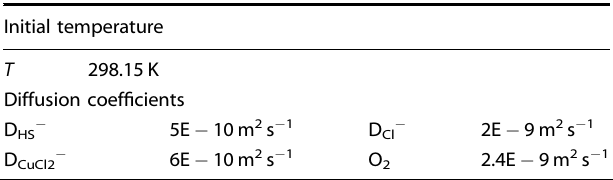
Table 5. Initial temperature and diffusion coef fi cients 29